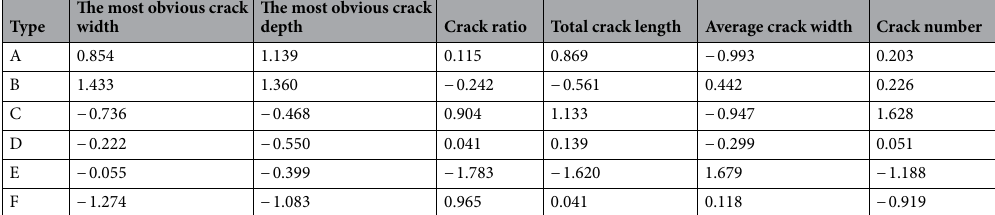
Table 5. Standardized processing results.